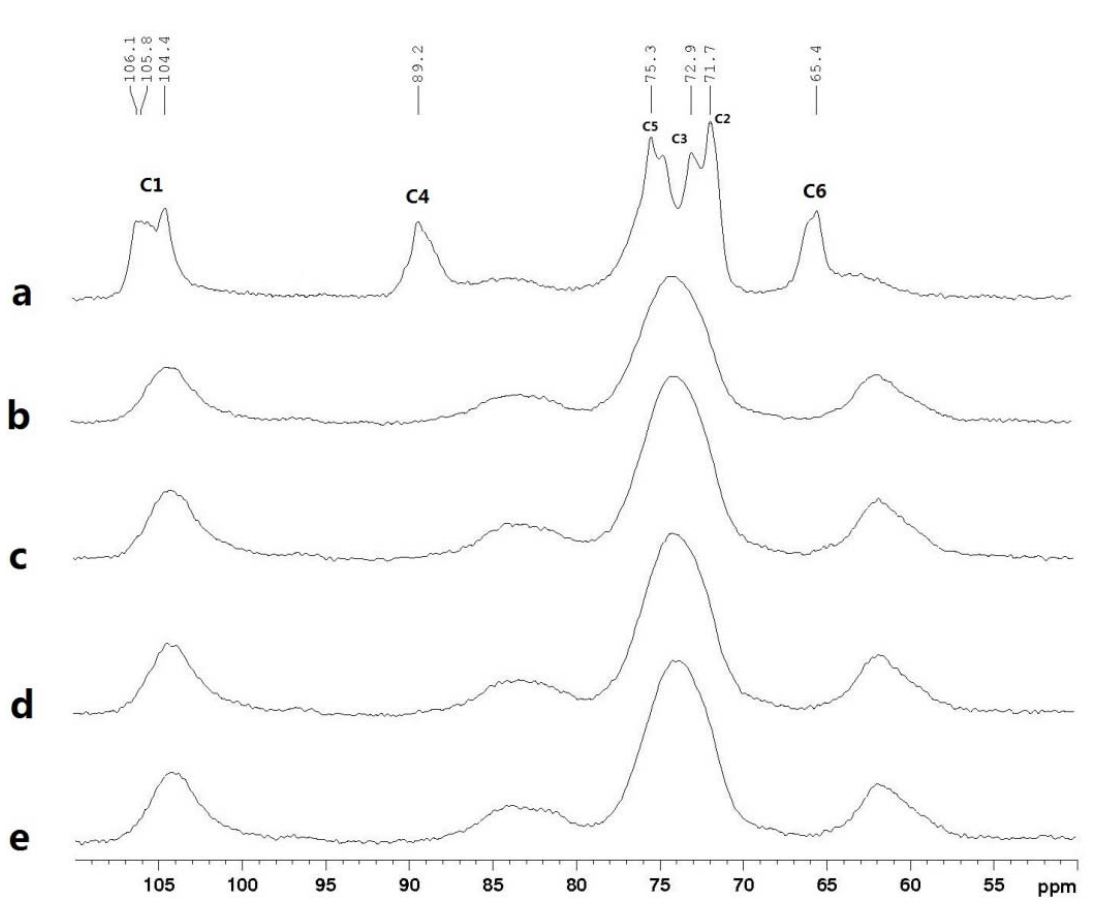
Figure 7. The 13 C solid-state cross-polarization/magic angle spinning nuclear magnetic resonance (CP/MAS NMR) spectra: ( a ) cotton linter; ( b ) control cellulose film; ( c ) cellulose film plasticized with sorbitol; ( d ) cellulose film plasticized with glycerol; ( e ) cellulose film plasticized with